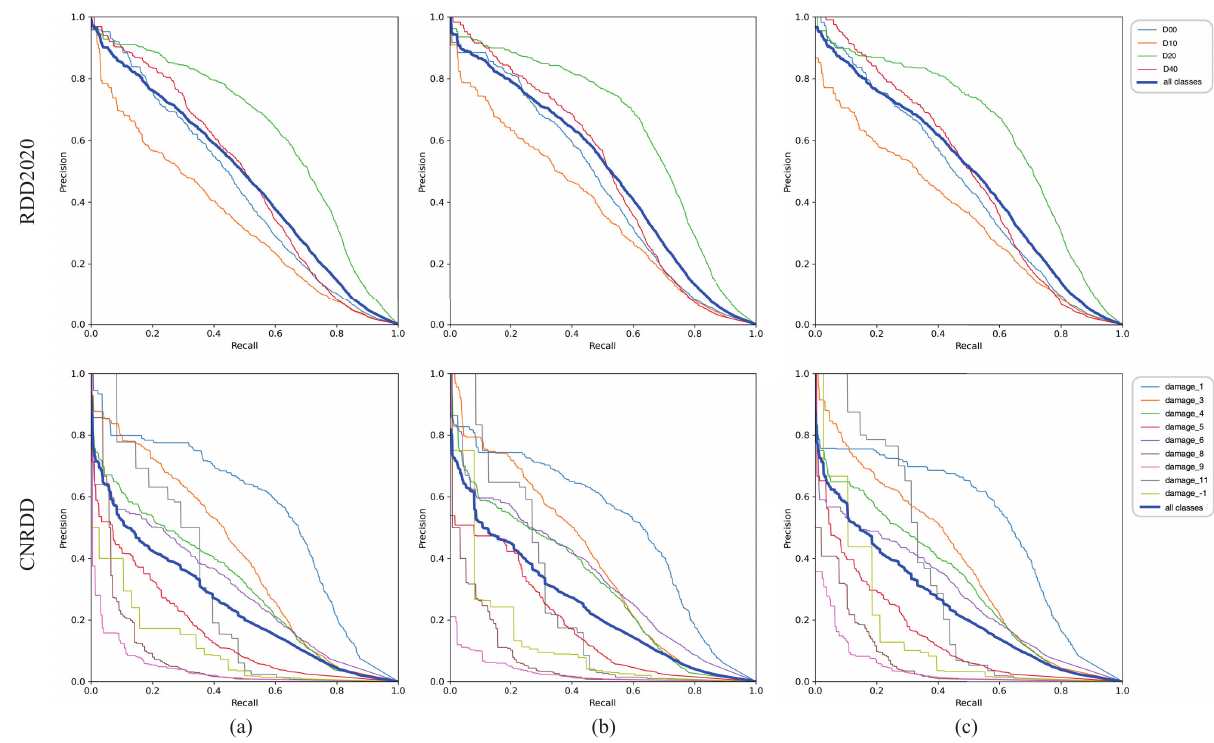
Figure 8. Precision–Recall curves from different methods. The data of ( a – c ) are from YOLO v5 [15], Faster R-CNN [12] and the proposed method, respectively. Different colors represent the detection results of different types of damage, and the corresponding relationship is shown in the